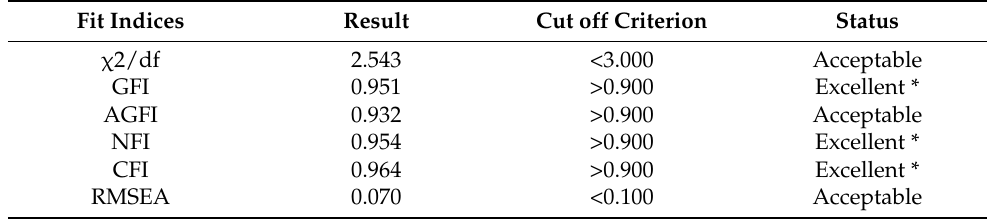
Table 3. The summary of the fit indices value.